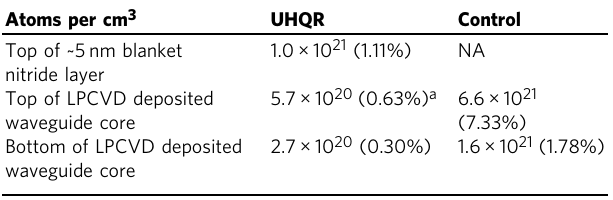
Table 2 Hydrogen concentration pro fi